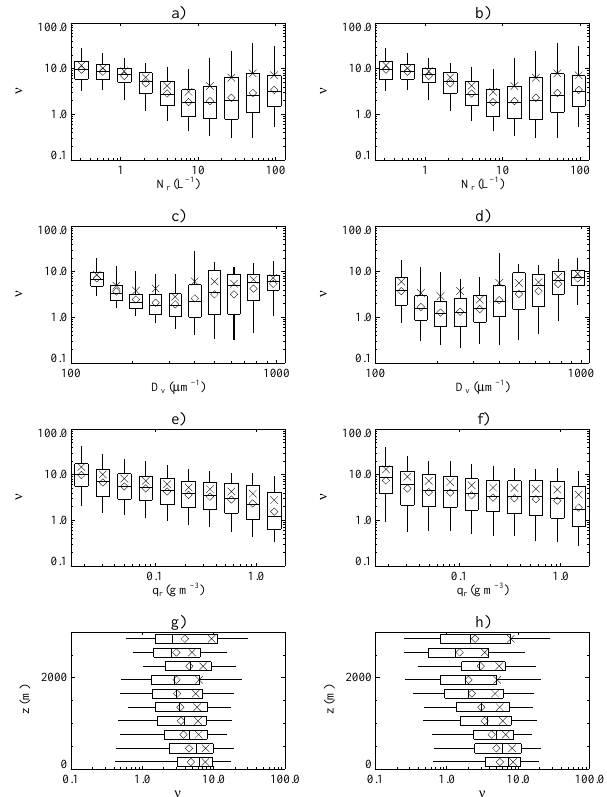
Figure 5. Statistical distribution of the shape parameter values as a function of rain number concentration N r (upper line), rain mean volume diameter D v (second line) and rainwater content (third line) and profile of the statistical distribution of the shape parameter val- ues (lower line) for the M 1 minimization (left column) and the M 4 minimization (right column). The box plots denote the 5th, 25th, 50th, 75th and 95th percentiles of the shape parameter distribution in each class. The diamonds and crosses denote the arithmetic mean and the geometric mean in each class,